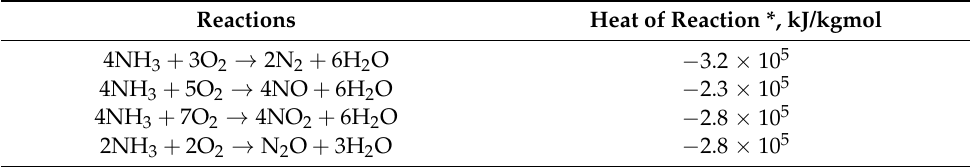
Table 10. Reaction heat for different reactions obtained by Hysys. Reactions